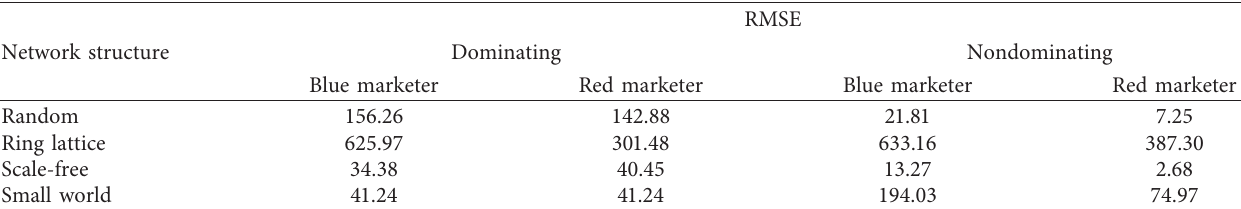
Figure 20: Simulation results for different network structures. Table 6: RMSE demonstrating the difference between fully connected network and other network